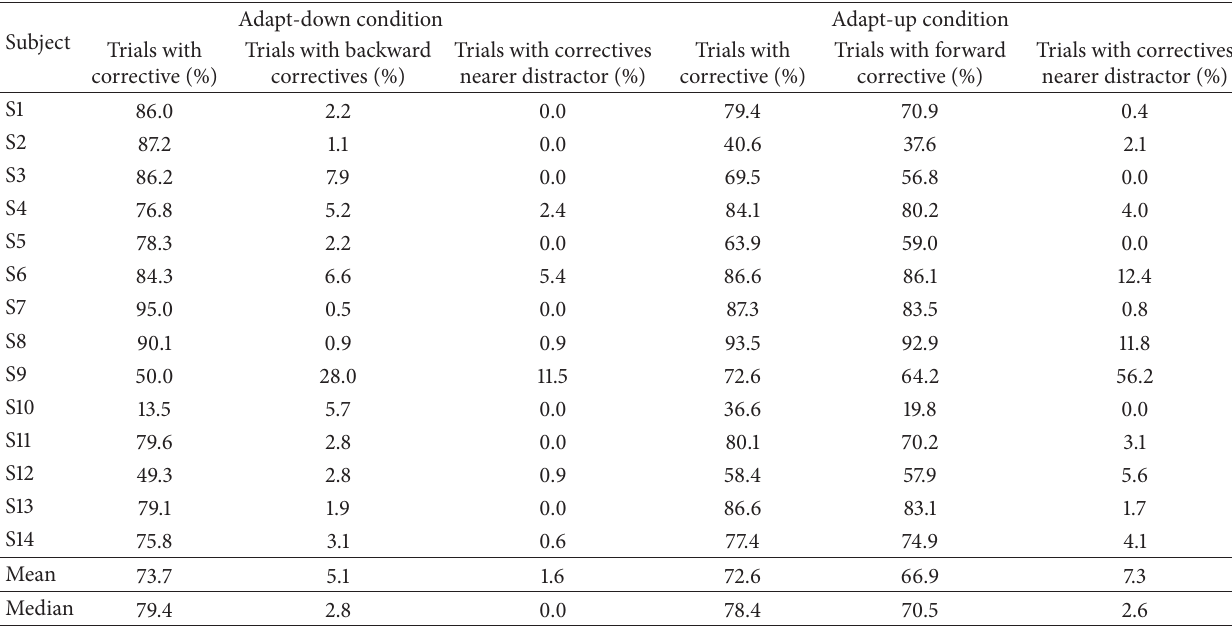
Table 1: Corrective saccades in Experiment 1. The percentage of adaptation trials with corrective saccades for the adapt-down and adapt-up condition, respectively, and the percentage of those that were in the direction of the distractor and that landed nearer the distractor compared to the saccade target.